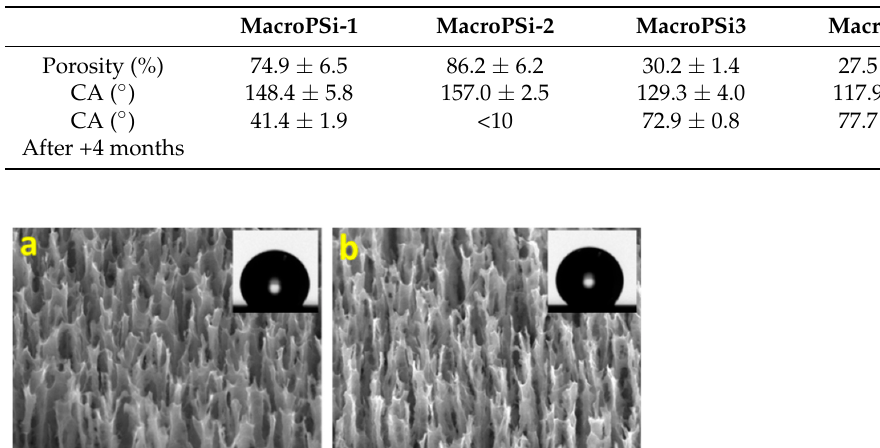
Table 2. Values of water contact angle in degrees for macroporous silicon substrates.